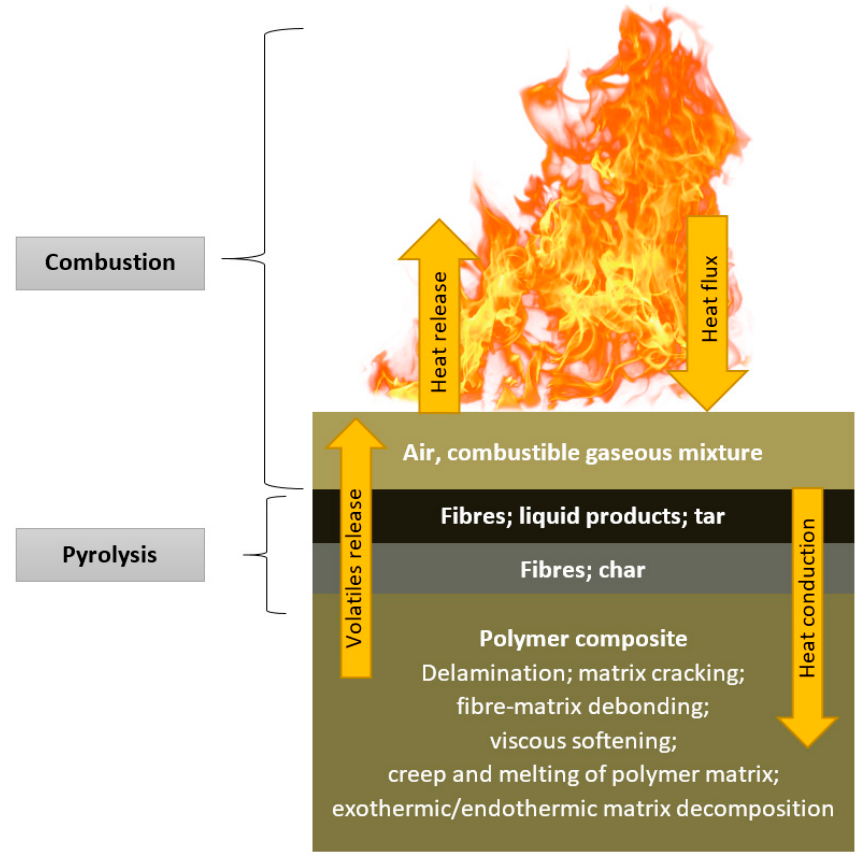
Figure 1. Diagram of the different phases, mechanisms, and reactions taking place during the exposure of the polymer to fire [13].